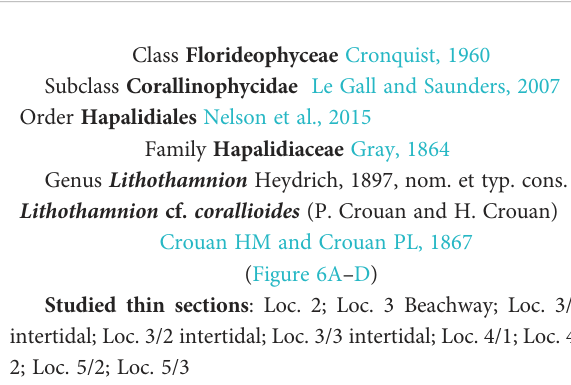
Description : Growth form encrusting to warty. Thallus monomerous, dorsiventral with non-coaxial core fi laments. Protuberances are up to 3 mm in thickness and 2.5 mm in